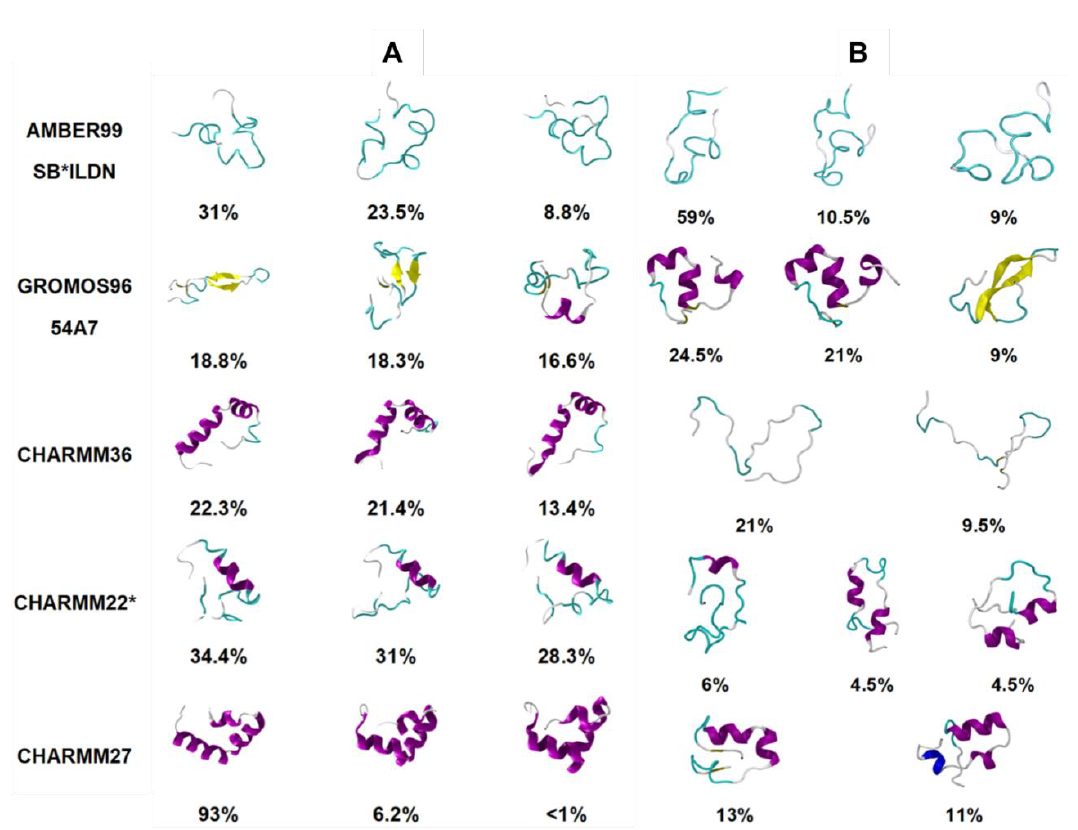
Figure 10. Conformational cluster analysis of REST2 simulations starting from ( A ) folded NMR structure and ( B ) disordered unfolded state of hIAPP. Top clusters for each simulation were selected to represent the most common conformations of the equilibrated trajectory. α -helix is represented in blue, β -sheet in yellow, random coil in white, and turn in cyan. Adapted from Peng et al. [89]. Copyright 2017 Peng et al.